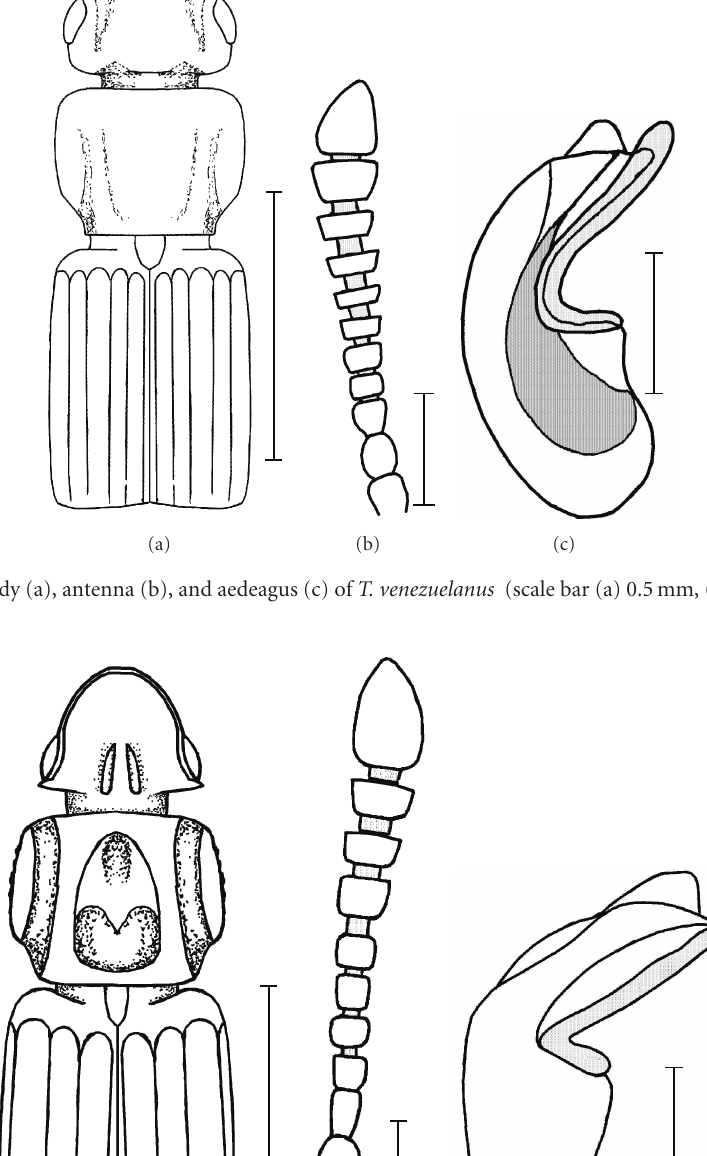
microsculpture; surface matte. Antennae as long as head and half of pronotum combined; with antennomeres 1 and 2 thicker than following antennomeres; 2nd antennomere oblong, 3rd conical; antennomeres 4 to 6 quadrate, following antennomeres increasing in width and wider than long; penultimate antennomere twice as wide as long. Pronotum : 0.38 mm long, 0.50 mm wide; widest in posterior third;